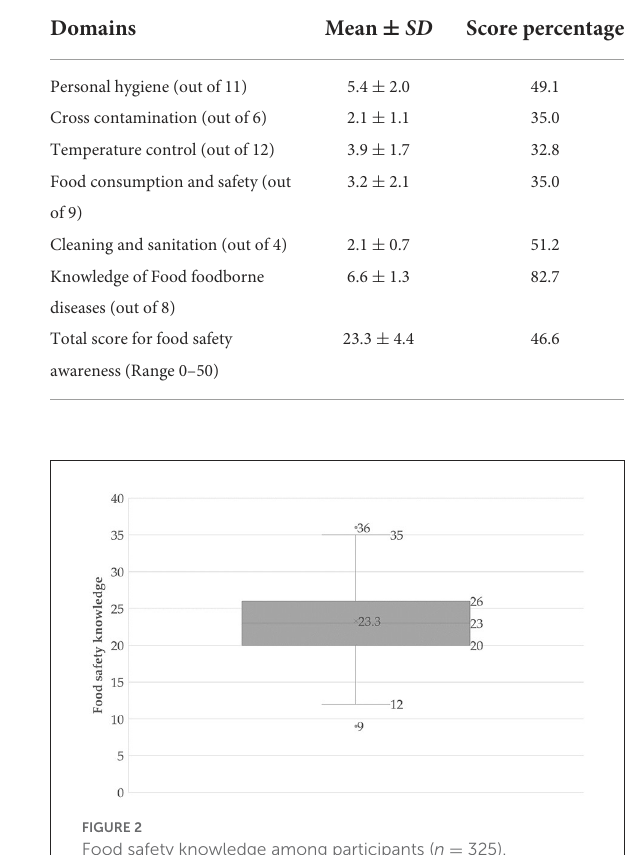
TABLE 2 Food safety score for study participants ( n = 325).